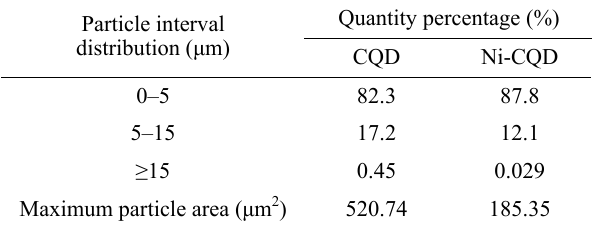
Fig. 11 Diameter distribution images of two kinds of Particles in PEG after friction. (a) CQD; (b) Ni-CQD. Table 2 Diameter distribution range of two kinds of particles in PEG after